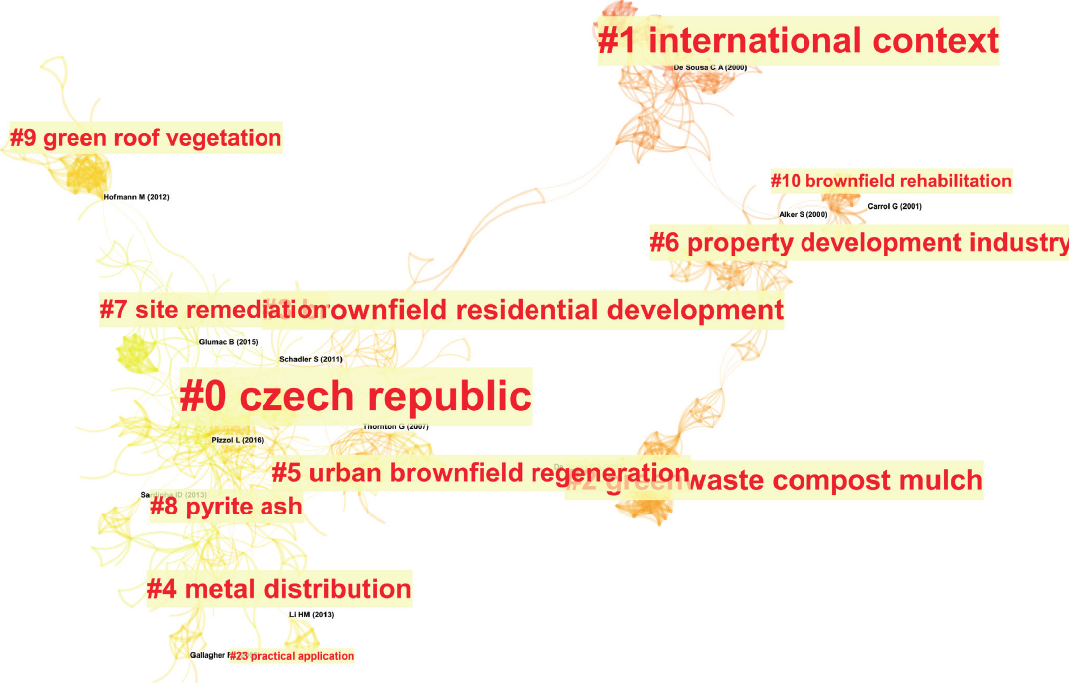
Figure 5: Document cocitation clusters of